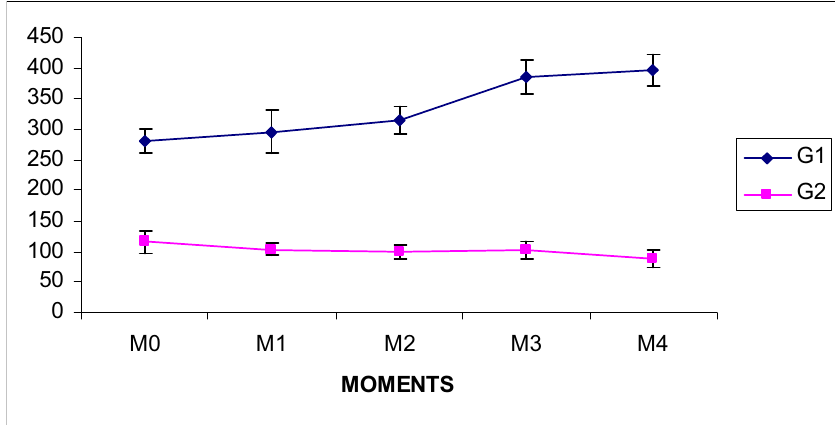
FIGURE 7 - Mean values for the rupture strength (g) of samples for the ileal segment in the two groups at the experimental moments